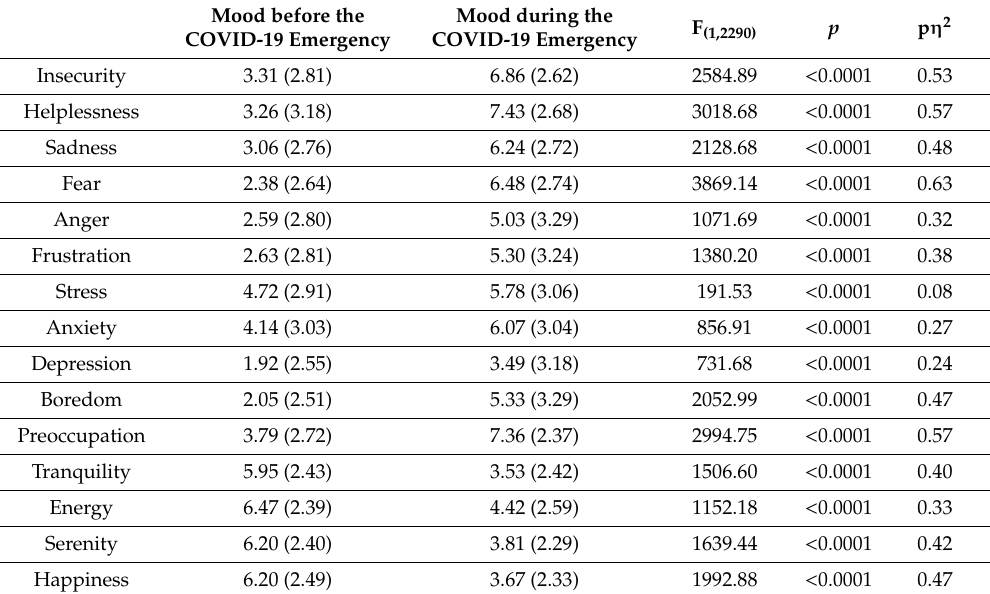
Mean and SD of self-reported mood before and during COVID-19 emergency, and ANOVA